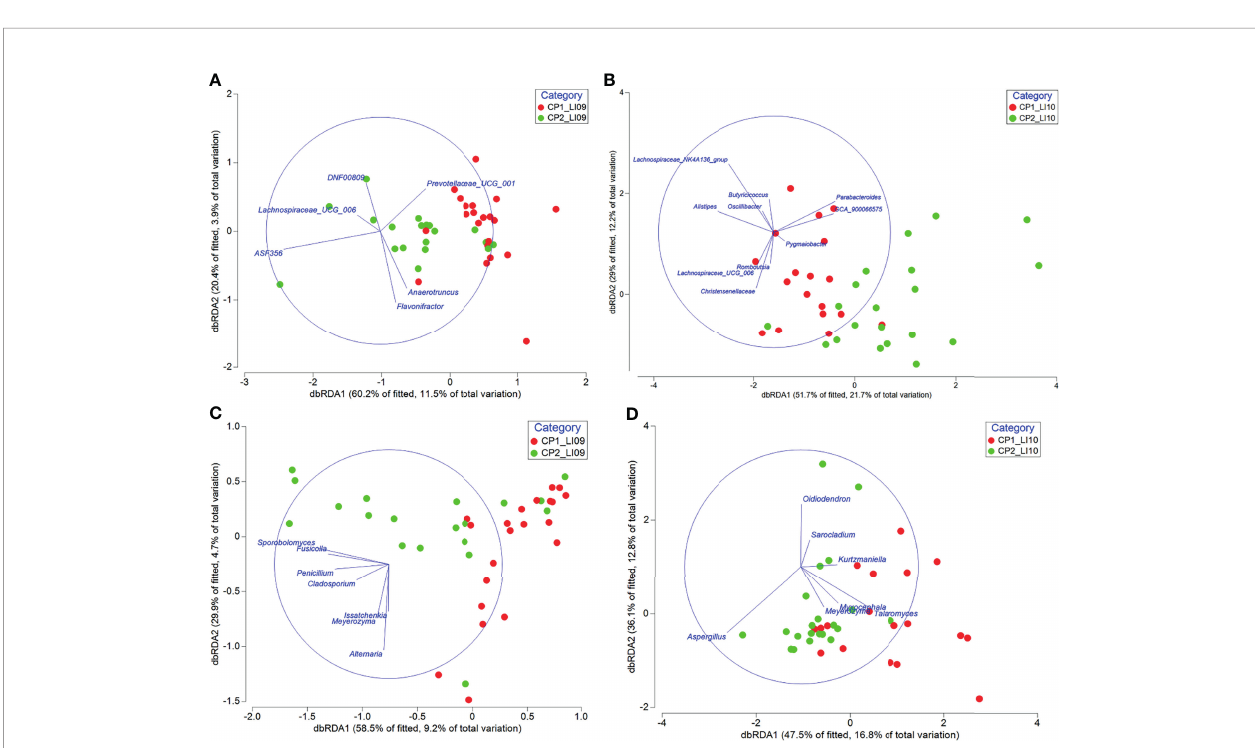
FIGURE 10 | Distance-based redundancy analyses revealed the impact of bacteria associated with (A) CP1_LI09 and CP2_LI09 and (B) CP1_LI10 and CP2_LI10 cohorts on the cytokine pro fi les of the corresponding cohorts, and the impact offungi associated with (C) CP1_LI09 and CP2_LI09, and (D) CP1_LI10 and CP2_LI10 cohorts on the cytokine pro fi les of the corresponding cohorts. Up to fi ve bacteria or fungi most associated with each cohort were selected for this analysis.